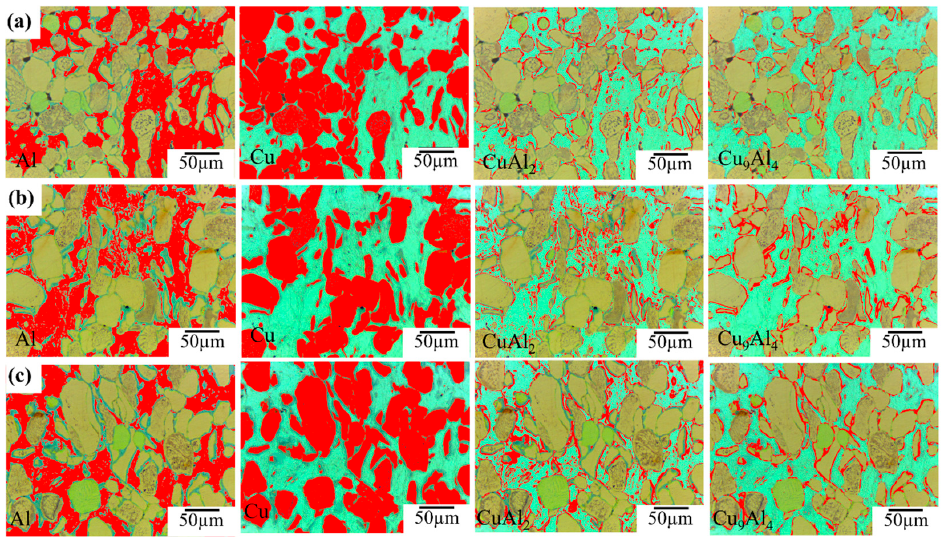
Figure 5. ImageJ analysis result with optical images: area of Cu, Al, CuAl 2 and Cu 9 Al 4 indicated by red colour in Al–50vol%Cu composites sintered at ( a ) 360 °C, ( b ) 380 °C, and ( c ) 380 °C.